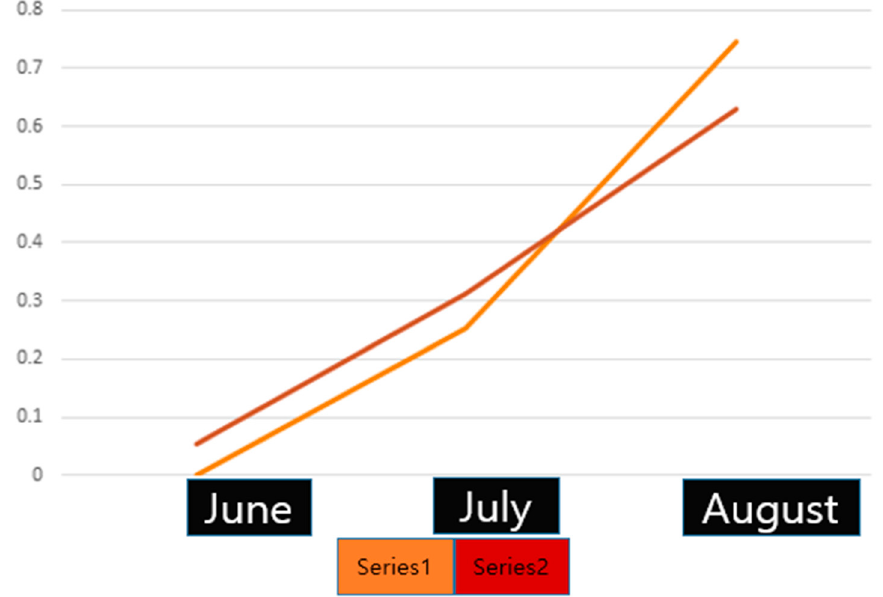
Figure 27. The frequency of appearance for the word “heat wave” and the changes in photovoltaic power generation in June, July, and August 2016.